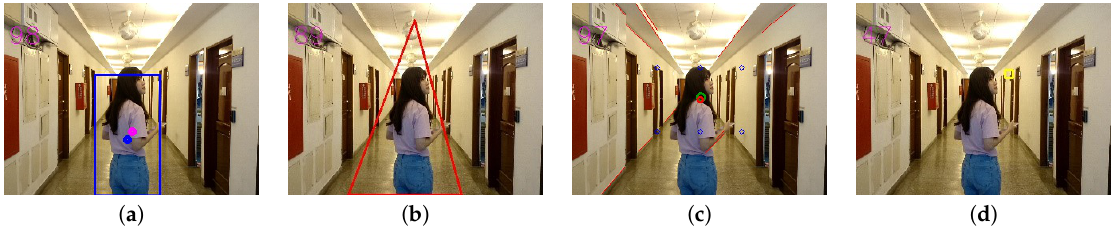
Figure 30. ( a ) Central composition. ( b ) Triangle composition. ( c ) Vanishing point composition (enlarge to see the red detected lines). ( d ) Focus composition (enlarge to see the detected focal point marked in yellow around the upper right region).